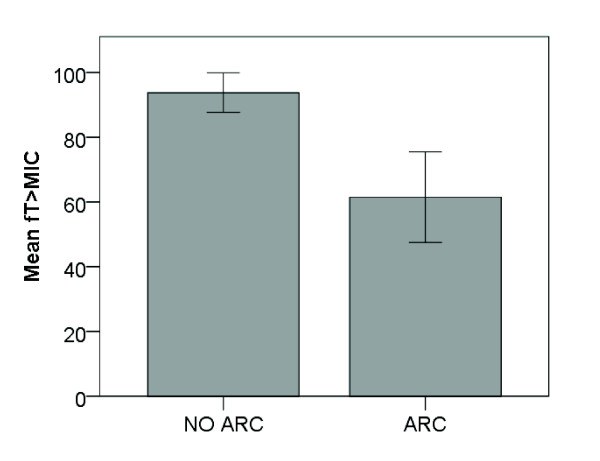
Mean % fT>MIC for patients with and without ARC.